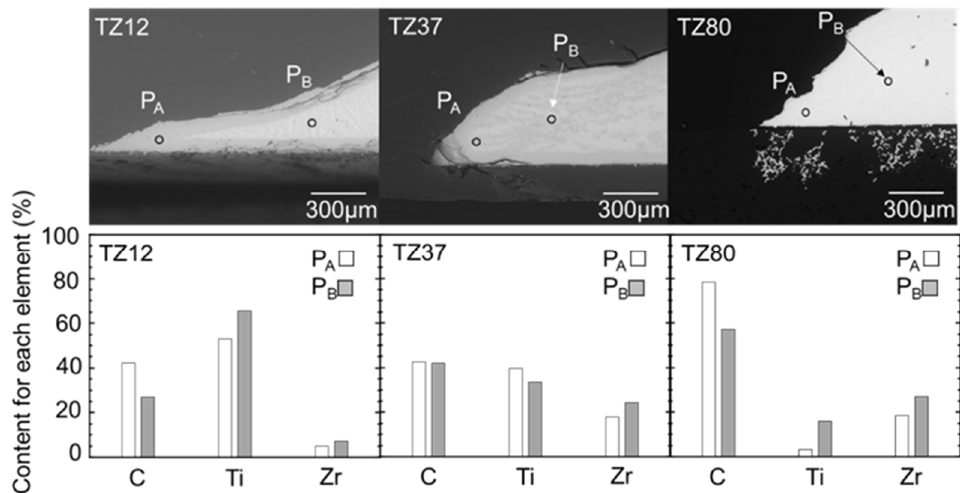
Figure 6. Enlarged backscattered electron (BSE) images of melted alloys on graphite plate along with results of energy- dispersive X-ray (EDX) point analysis for C, Ti, and Zr.